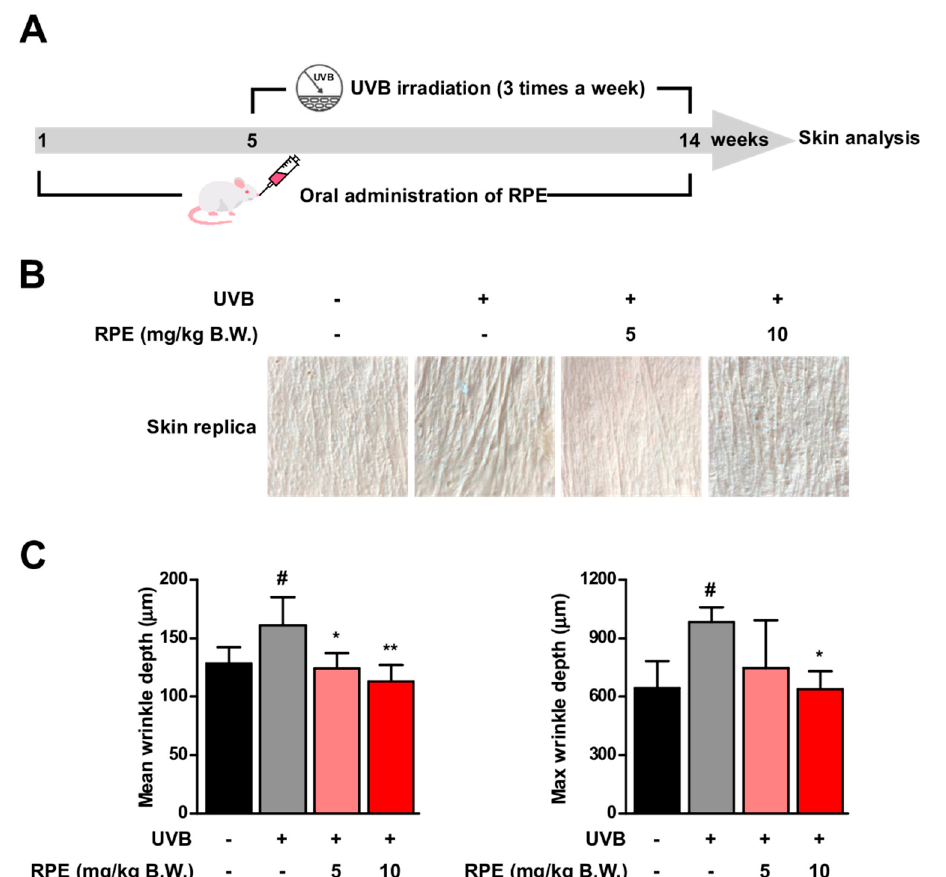
Figure 1. Rose petal extract (RPE) suppresses UVB − induced skin wrinkle formation. ( A ) RPE was orally administered to mice every day. UVB was irradiated three times a week as indicated in the experimental scheme. ( B ) Representative pictures of skin replica. ( C ) Mean wrinkle depth and max wrinkle depth were quantified. Data represent the means ± SD ( n = 4). Significant differences between un − treated control and UVB − only treatment group (# p < 0.05) and significant differences between UVB and UVB + RPE administrated group (* p < 0.05, ** p < 0.01).